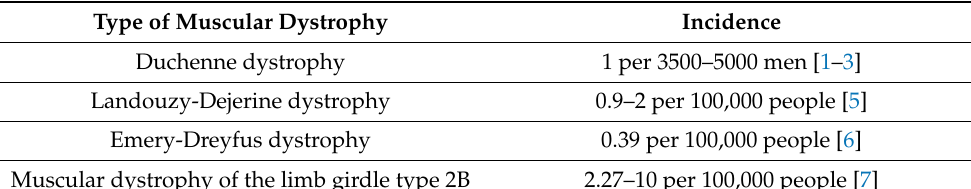
Table 1. Prevalence of various forms of muscular dystrophies in the population. Type of Muscular